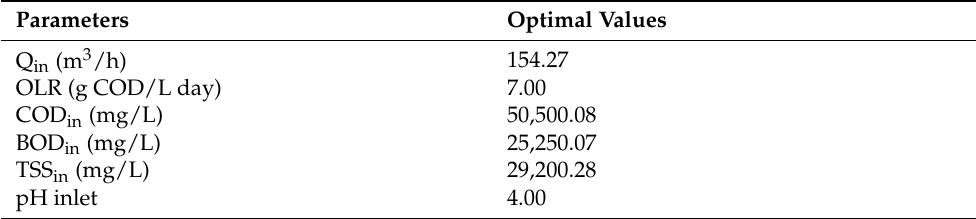
Table 5. Optimal operating condition for maximum methane yield from anaerobic digestion.